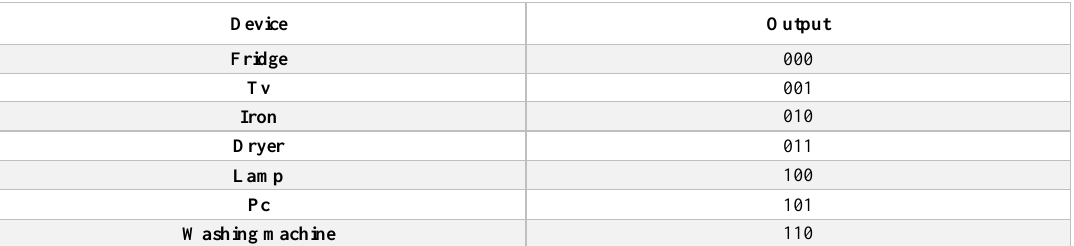
Table 2. Expected outputs in the